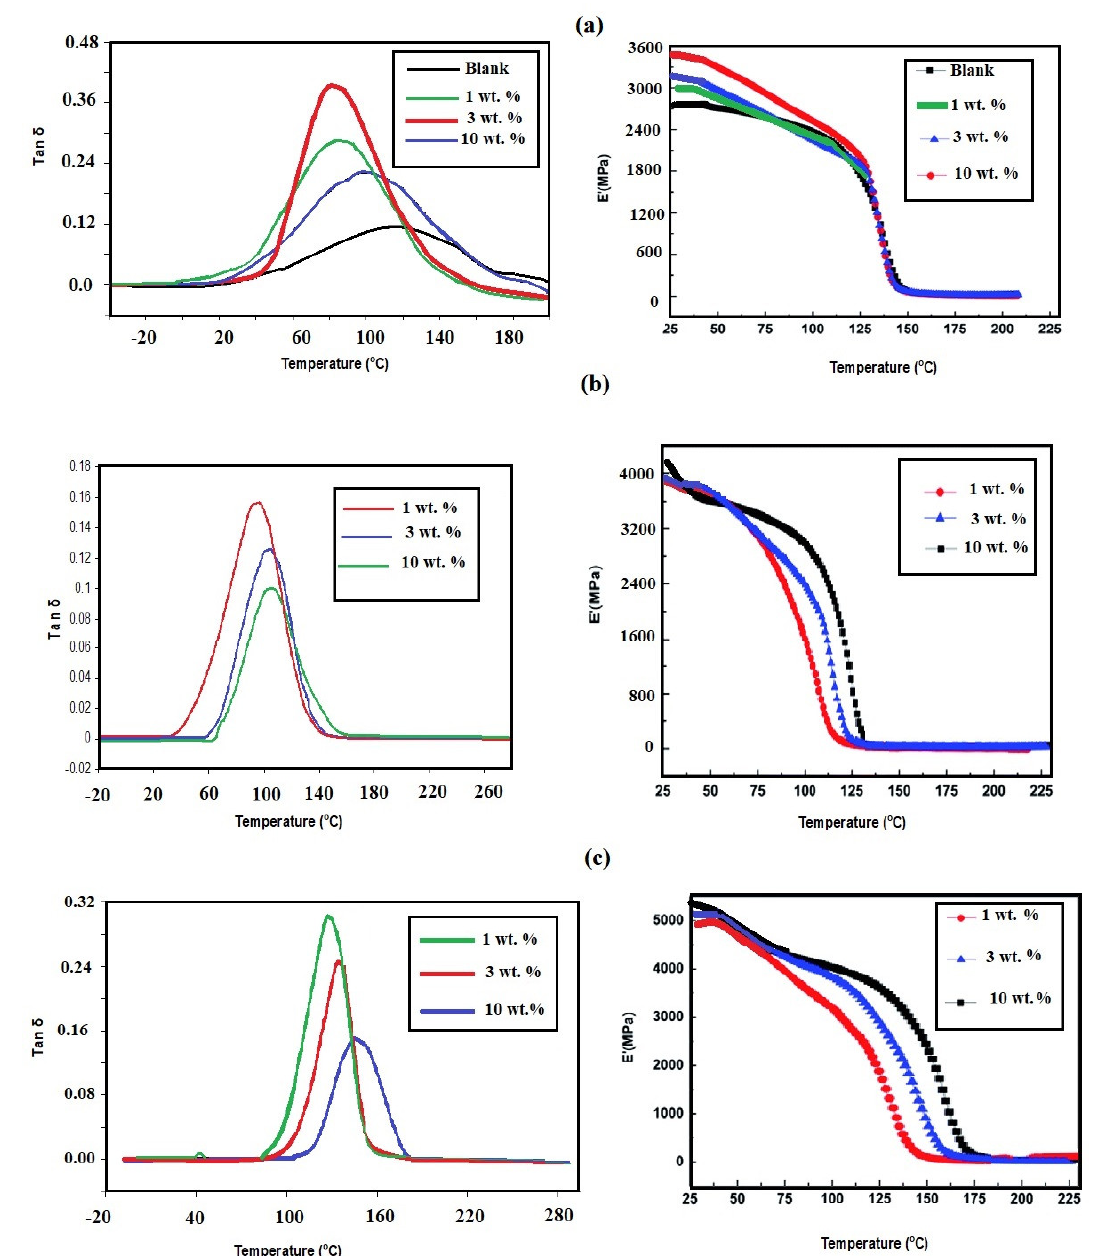
Figure 13. DMA analyses based on the relation of the tan δ or storage modulus versus curing temperatures of the cured DGEB/PA in the presence of different wt % of modified ( a ) EOA-Fe 3 O 4 , ( b ) EOA-TiO 2 and ( c ) Ag NPs.